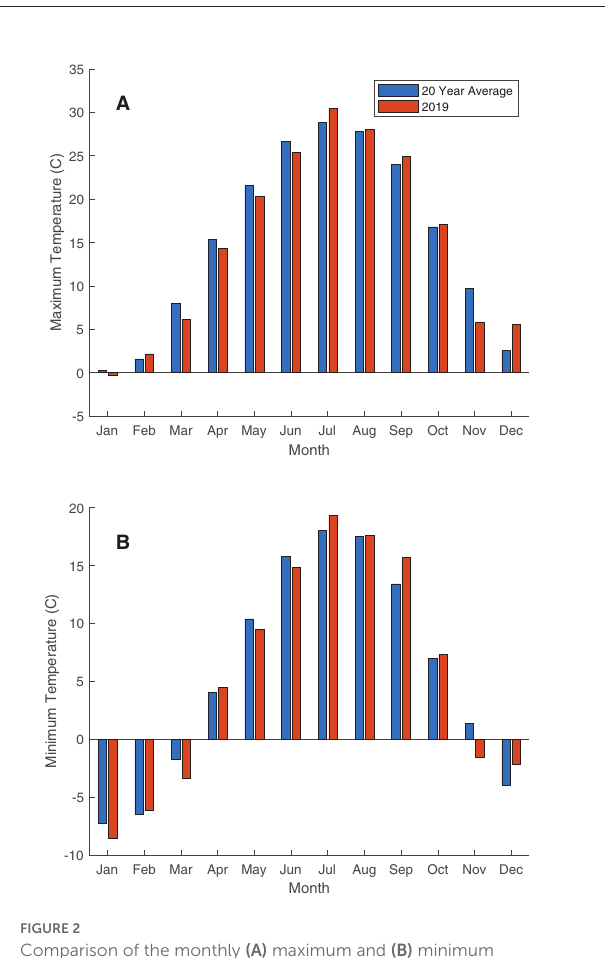
FIGURE2 Comparison of the monthly (A) maximum and (B) minimum temperatures in 2019 (red bars) to the 20-year (2000–2019) mean (blue bars) for